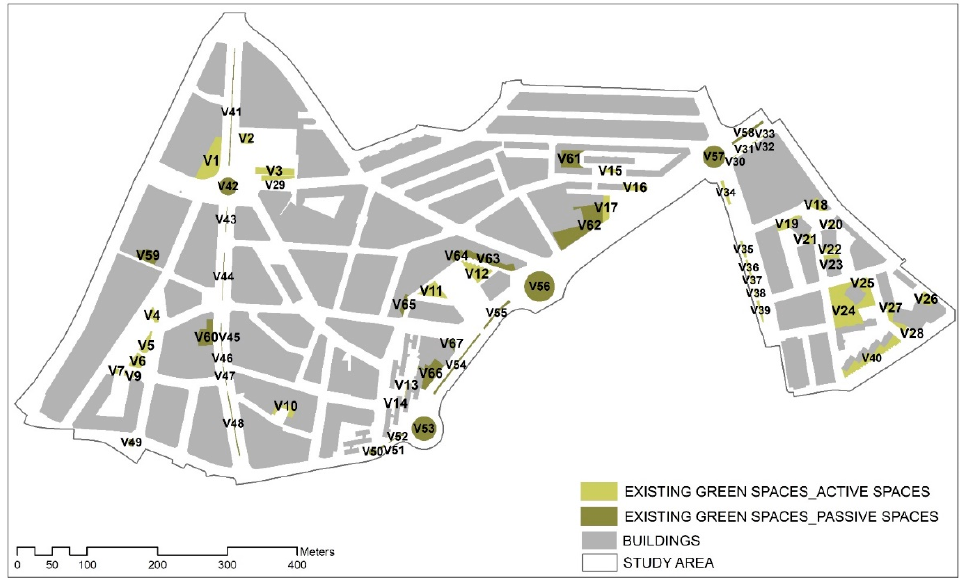
Figure 4. Existing green spaces in the neighbourhood of La Milagrosa. The inventory identified a total of 67 green spaces (22,110.7 m 2 ), ranging in size from 10.59 m 2 for the smallest space to 1733.4 m 2 for the largest space (Table 1). Table 1. Existing green